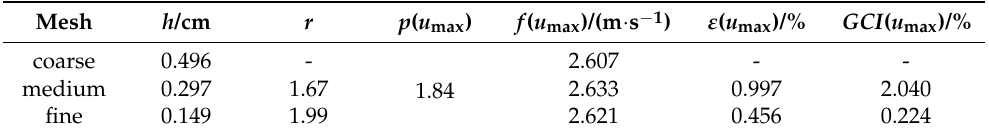
Table A1. Parameter of grid convergence calculation.